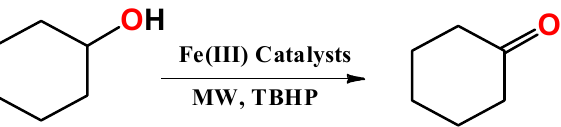
Figure 6. Cyclic voltammogram, initiated by the cathodic sweep, of ( A ) 4 or ( B ) HL in a 0.2 M [ n Bu ][ BF ] /DMSO solution, at a Pt disc working electrode ( d = 0.5 mm), run at a scan rate of 100 4 N 4 mVs − 1 . * [ Fe( η 5 -C 5 H 5 ) 2 ] 0/+